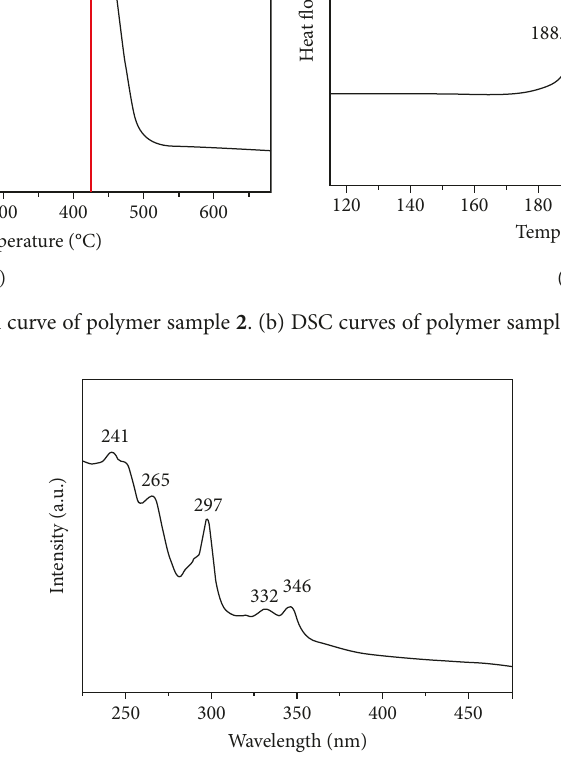
Figure 7: UV-vis absorption spectra of polymer sample 2 fi lms.